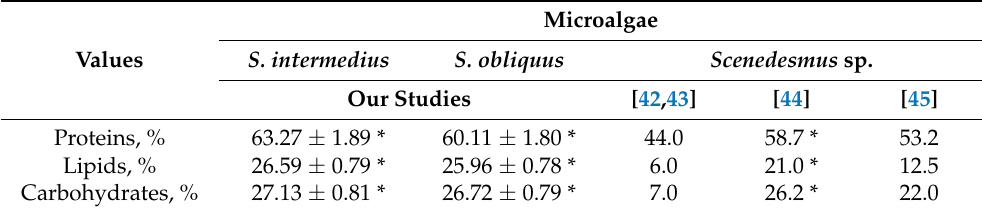
Table 5. The content of proteins, lipids, and carbohydrates in the samples of S. typhimurium and S. obliquus microalgae obtained in various